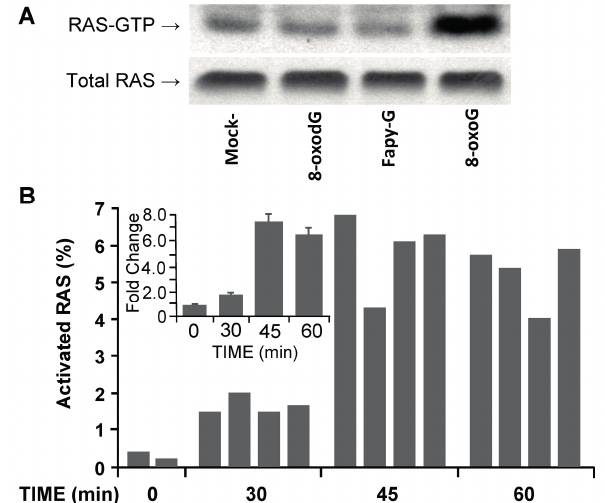
Figure 2. Activation of rat sarcoma–small guanosine triphosphatases (RAS–GTPases) in lungs by 8-oxo-7,8-dihydroguanine (8-oxoG) challenge. ( A ) Challenge of airways with